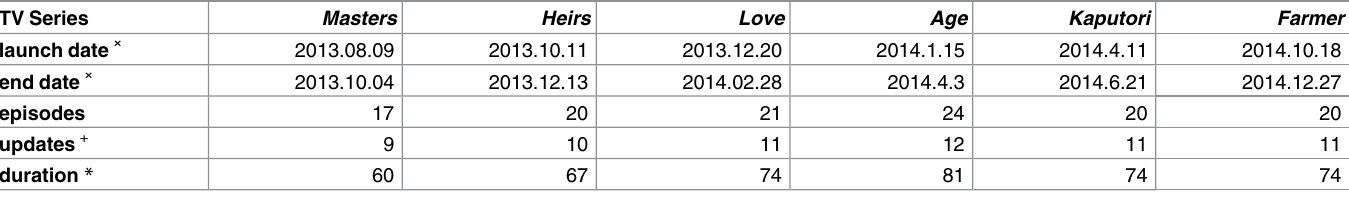
Table 1. Six popular South Korean TV